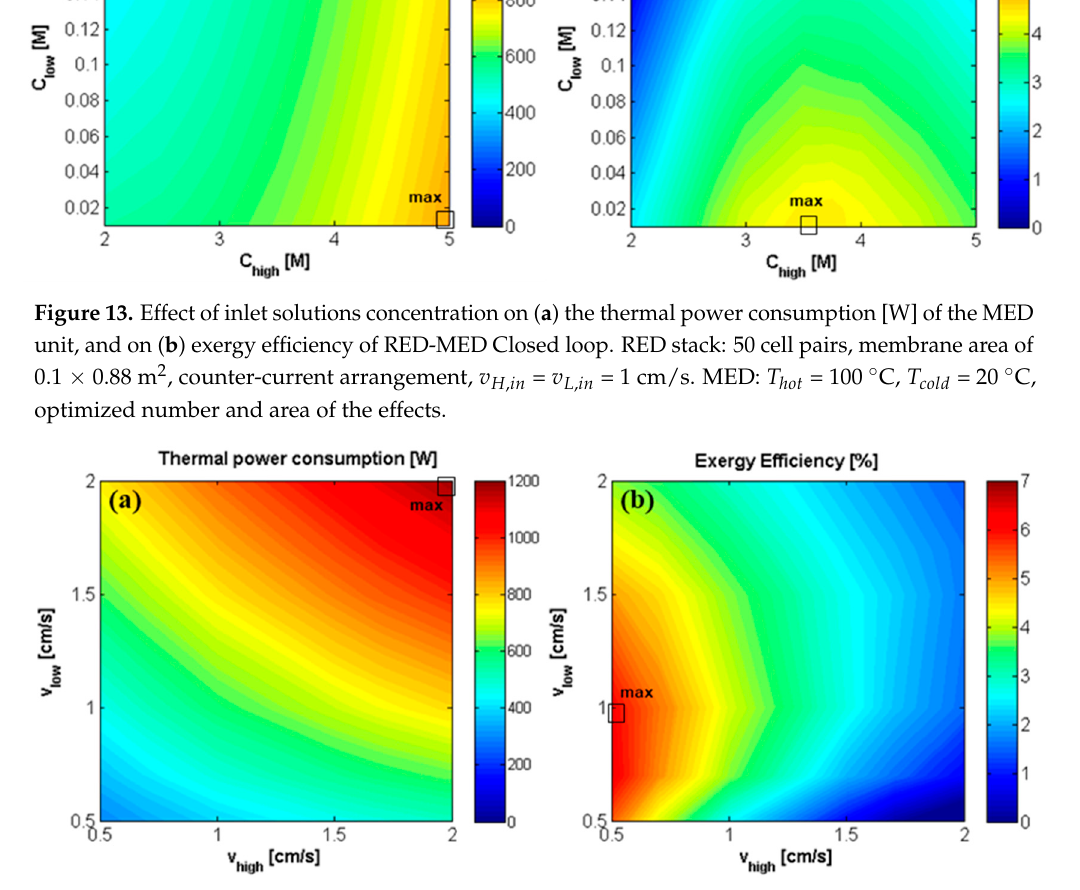
Figure 14. Effect of inlet solutions velocity on ( a ) the total thermal power consumption [W] of the MED unit, and on ( b ) exergy efficiency of the RED-MED system. RED stack: 50 cell pairs, membrane area of 0.1 × 0.88 m 2 , counter-current arrangement, C H , in = 3.5 M and C L , in = 0.01 M. MED: T hot = 100 ◦ C, T cold = 20 ◦ C, optimized number and area of the effects.